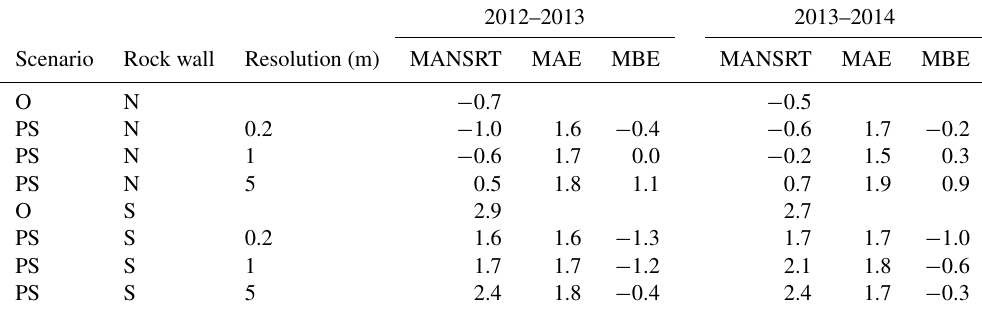
Table 4. Differences in grid resolution: MANSRT, MAE and MBE (all in ◦ C) calculated within the individual N- and S-facing rock walls at NSRT locations. The MAE and MBE were calculated between measurements (O) and model results of the snow-covered scenario (PS) at NSRT locations for 0.2, 1 and 5m grid